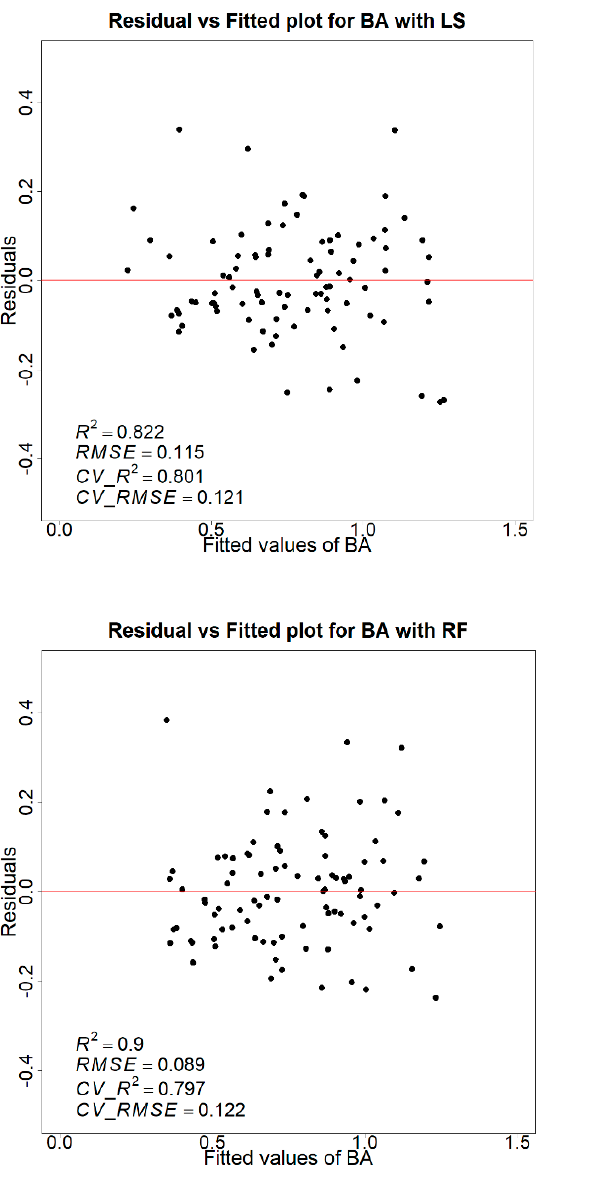
Figure A2. Each panel shows the residual vs. fitted plot for the basal area with LS, ALASSO, RF, and GAMSEL models. R 2 and RMSE are the model accuracy before cross-validation, and CV_R 2 and CV RMSE show the model accuracy result of nine-fold cross-validation.